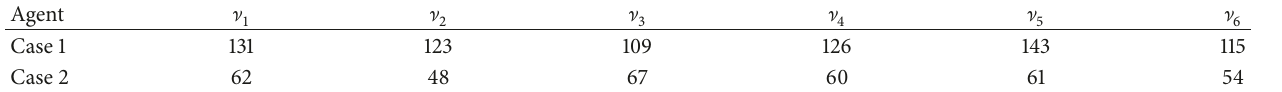
Table 3: Event times of all agents.